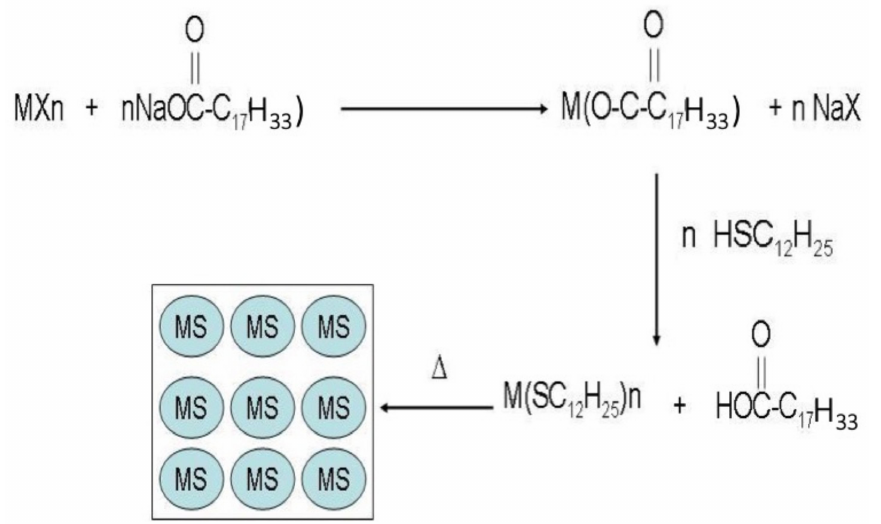
Figure 2. Squematic representation of Korgel’s method. The first two steps are in solution and corre- spond to the preparation of the solid precursor. The third step corresponds to the solid thermolysis of the M(SC 12 H 25 ) n